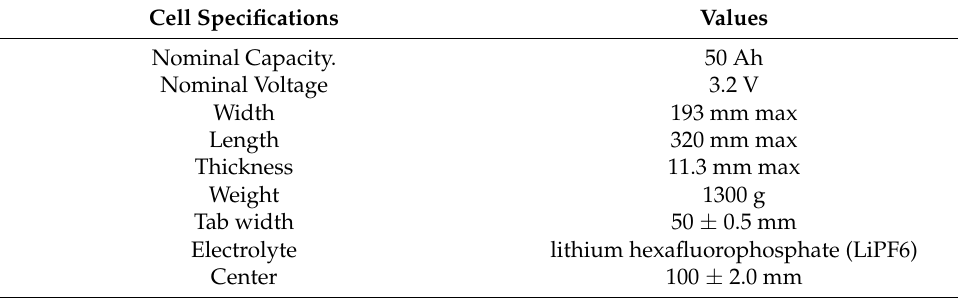
Table 1. Model: GPLFP 11192320ES-50 Ah.